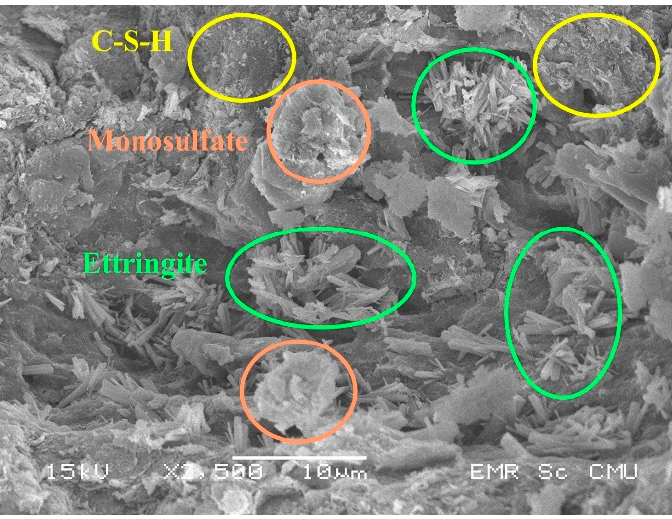
Figure 15. The SEM image of C2G5.